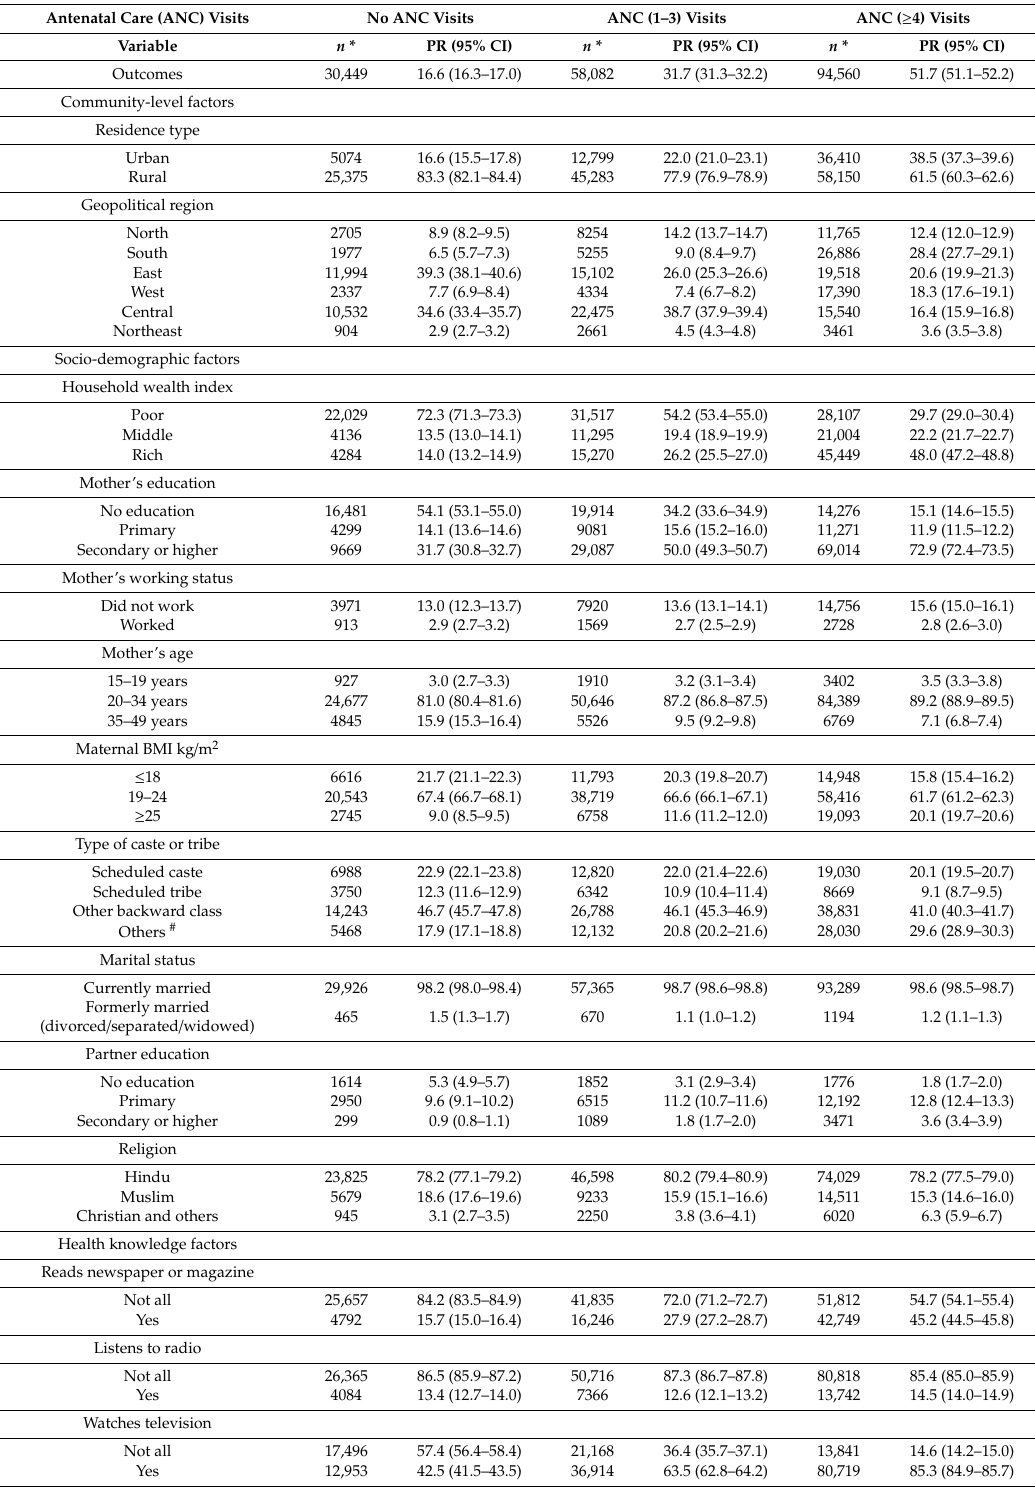
Table 1. Prevalence (PR) with corresponding 95% confidence interval (95% CI) of the frequency